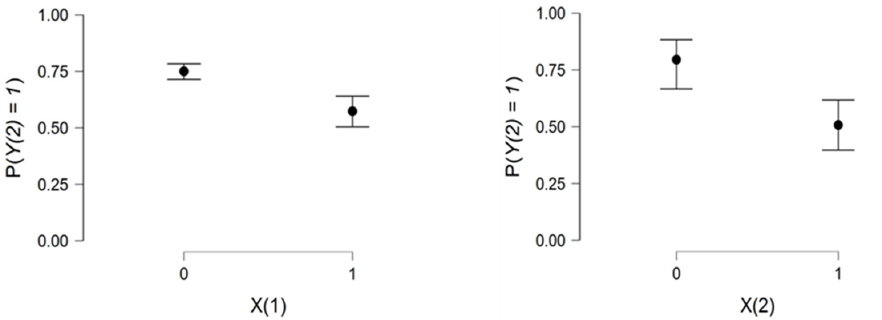
Figure 4. The relationship between age and the dependent variable Y 2 and the two explanatory variables X 1 and X 2 .